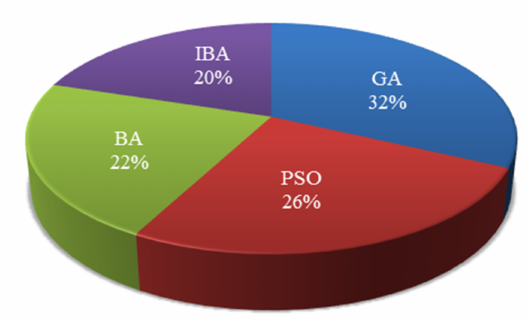
Figure 14. GWO cost saving compared with other algorithms in Scenario